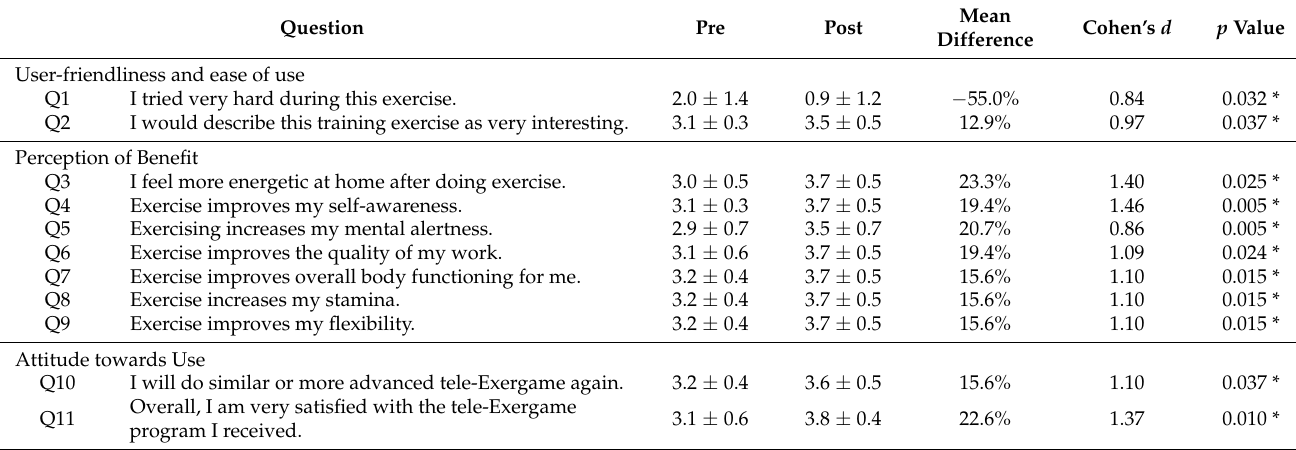
Table 2. Statistical analysis results of the Technology Acceptance Model (TAM)